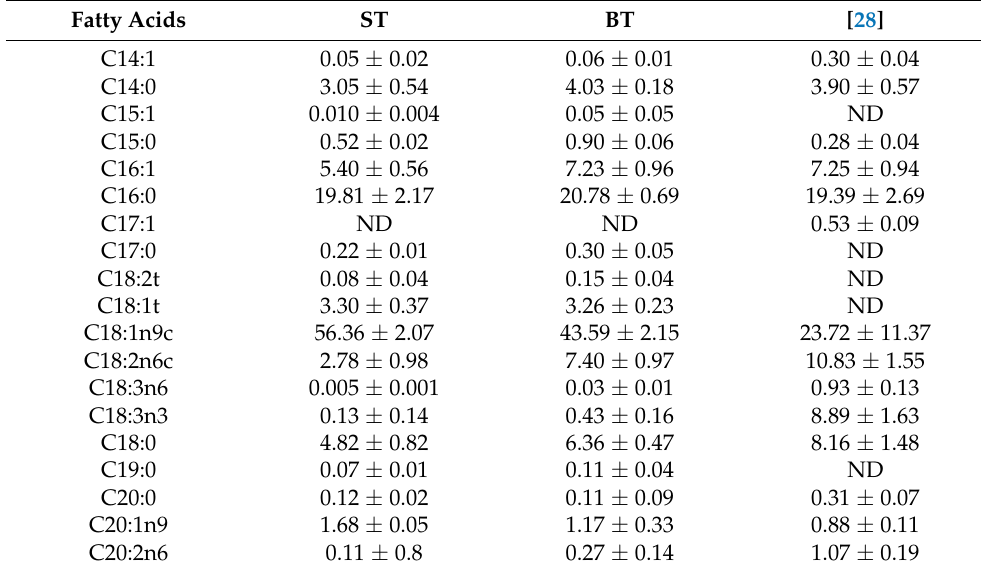
Table 3. Fatty acid composition % of ST and BT skin. ND = not detected. Results are expressed as mean value ±